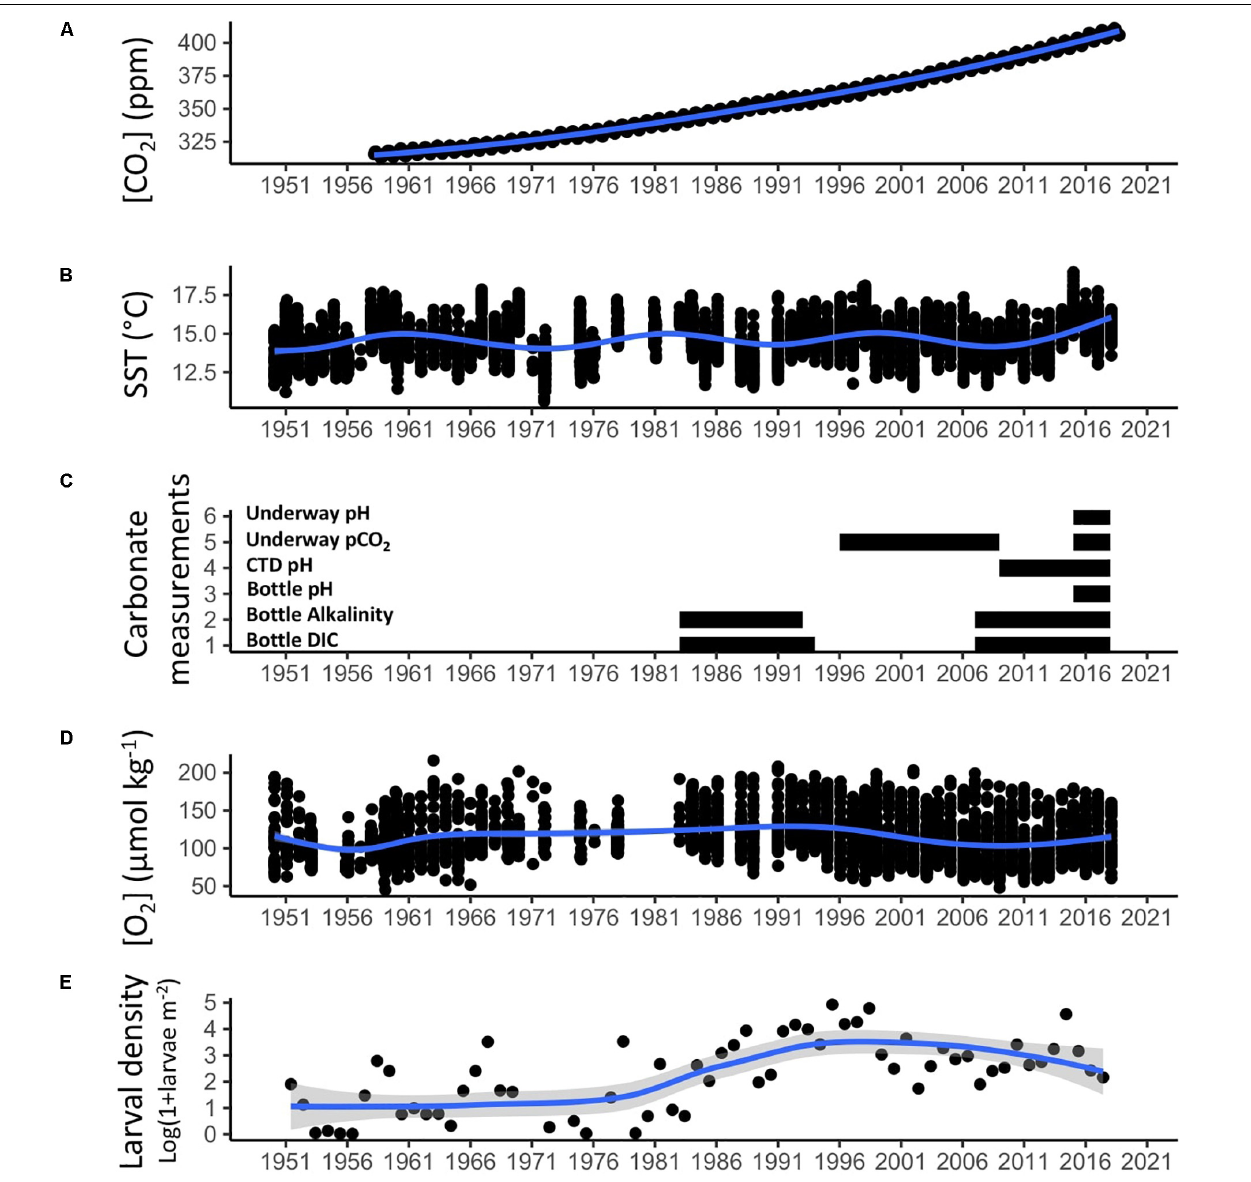
FIGURE 2 | The CalCOFI time-series is a Keeling Curve for the California Current Ecosystem. The Keeling Curve (A) shows the increase in atmospheric CO 2 at Mauna Loa through the twentieth and twenty-first century and is an essential record for understanding climate forcing. The CalCOFI record (B–E) extends a similar length and is an essential record of how the ocean responds to climate forcing through hydrographic and biological changes. Unlike the atmospheric record, the oceanic record is noisy and shows pronounced multi-decadal natural variability. Trends in winter sea surface temperature (SST) across the core 66-station CalCOFI grid are shown in (B) , the extent of all carbonate chemistry measurements taken on CalCOFI cruises is shown in (C) , trends in winter dissolved oxygen at 200 m across the core 66-station CalCOFI grid are shown in (D) , and trends in the annual mean density of Panama Lightfish, a warm-affinity mesopelagic species, across the core 66-station CalCOFI grid is shown in (E) . Blue trend lines show smoothed conditional